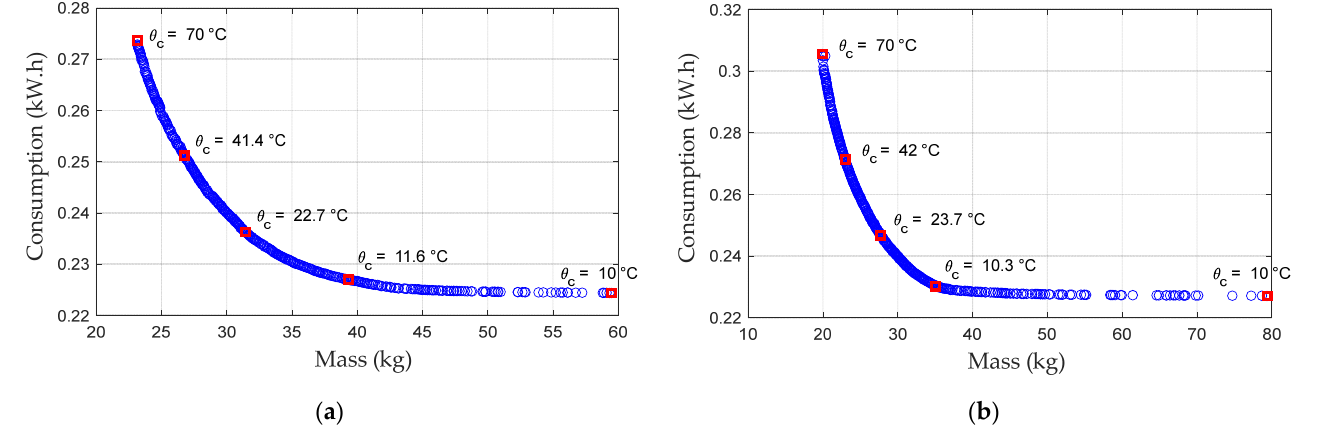
Figure 7. Pareto optimal front with temperature elevation in continuous ( a ) and intermittent ( b ) duties.